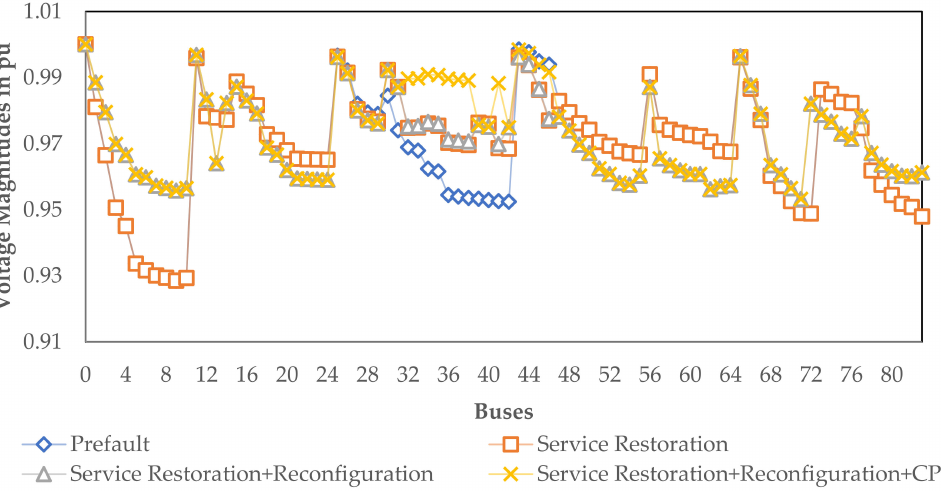
Figure 14. Bus voltage of test case 2 under MFC at zones 7 and